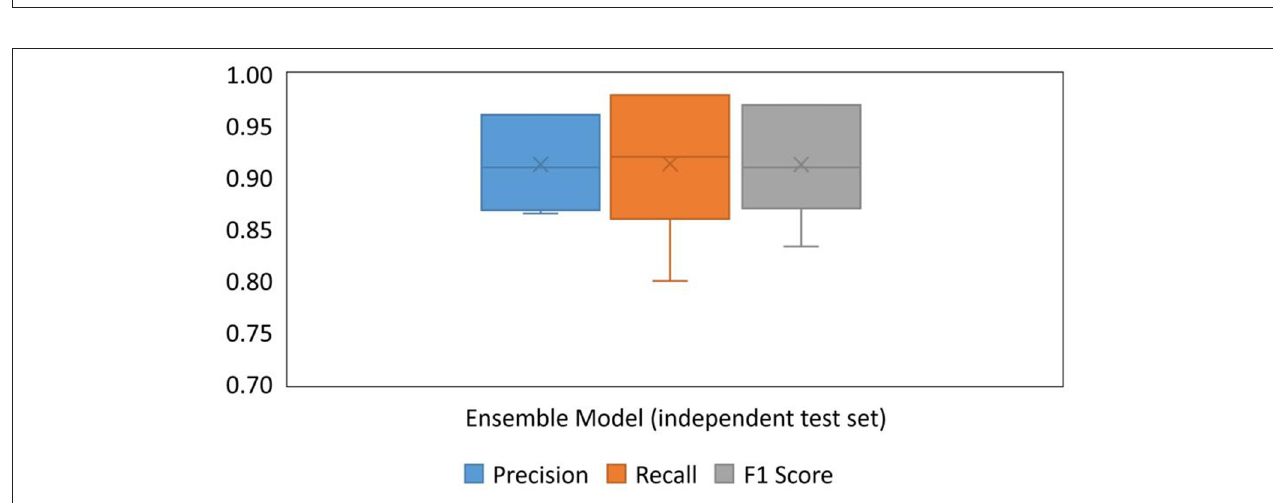
FIGURE 10 | Components of the user interface in the rice disease diagnosis app.